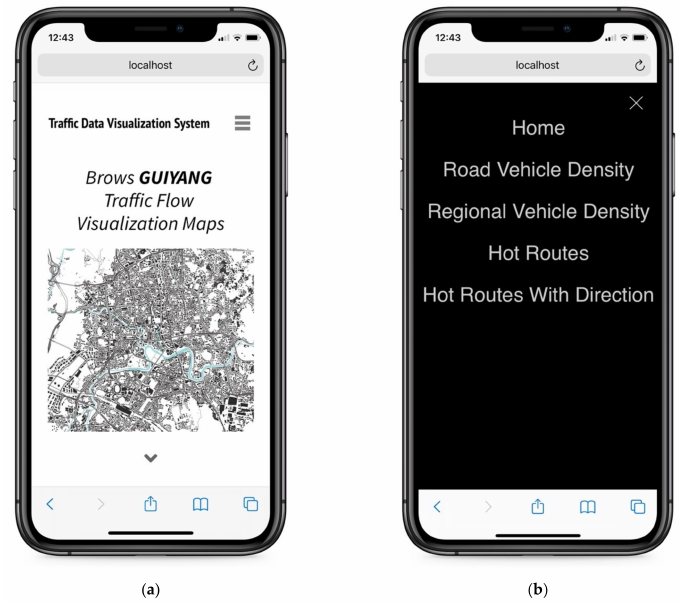
Figure 11. The mobile devices interface. ( a ) Home page. ( b ) Menu Bar.